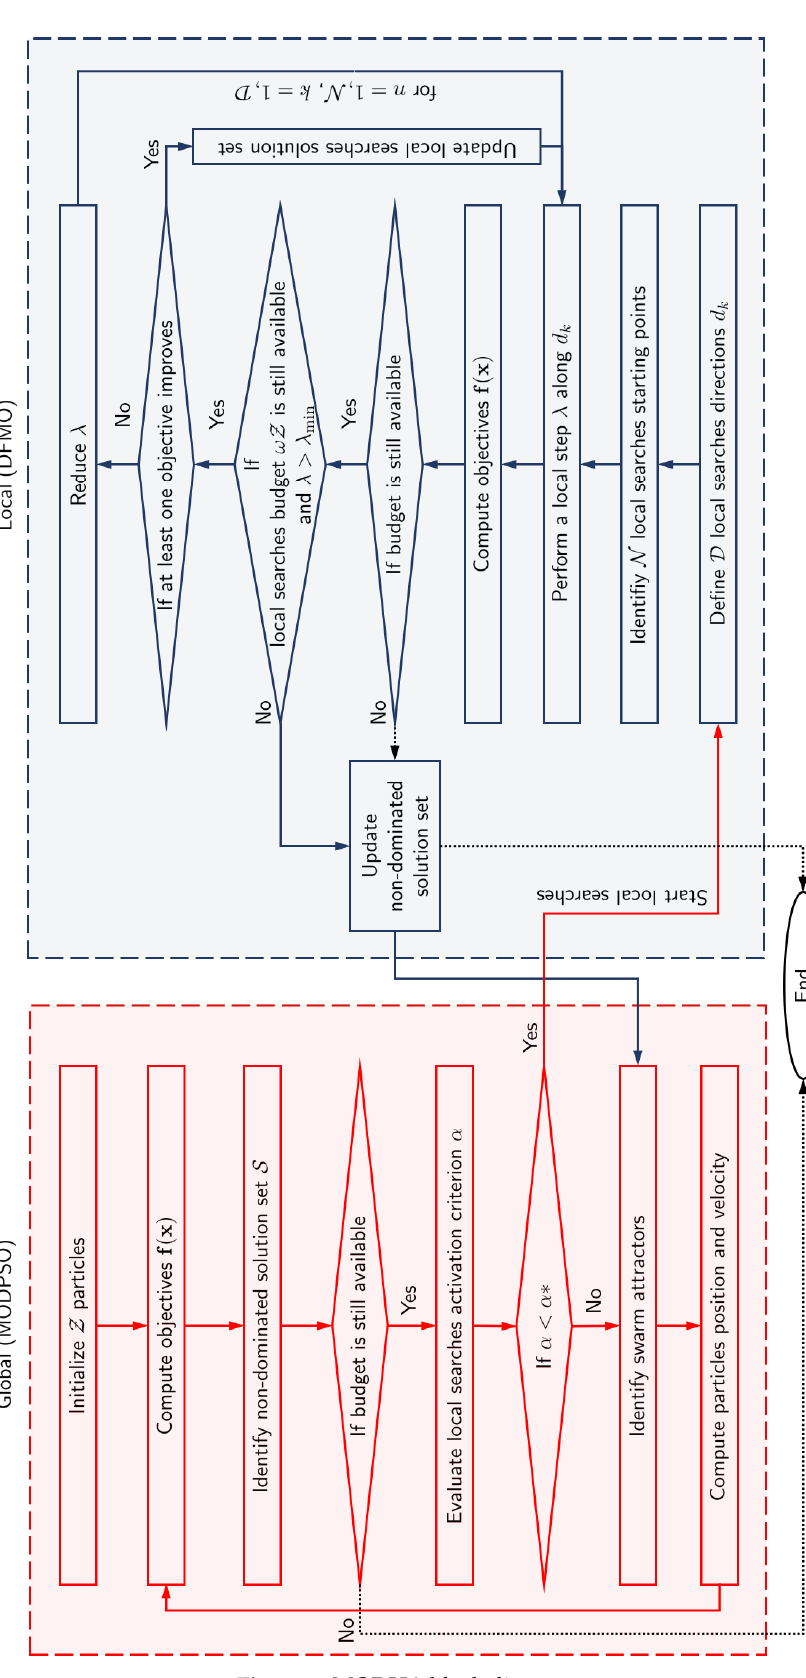
Figure 3. MODHA block